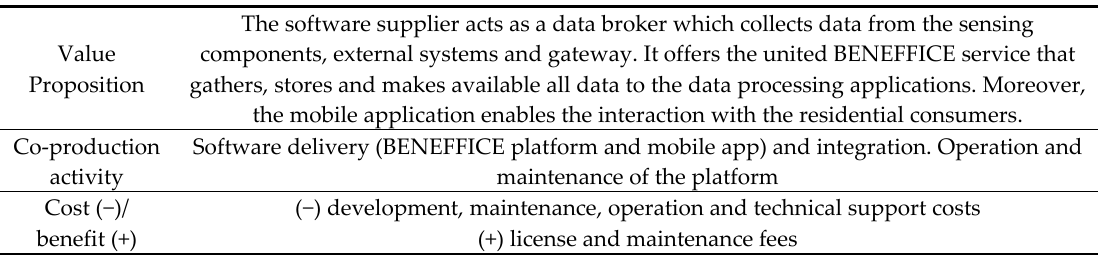
Table 2. Software Supplier (mobile application, platform backend).